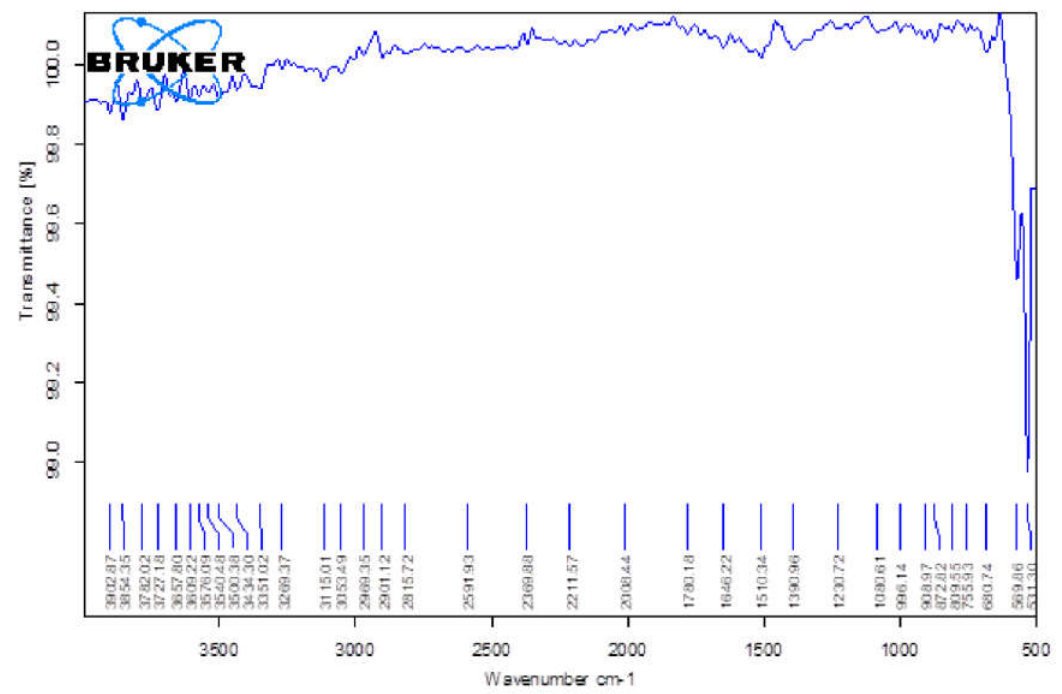
Figure 4. FTIR spectrum of ZnO NPs.